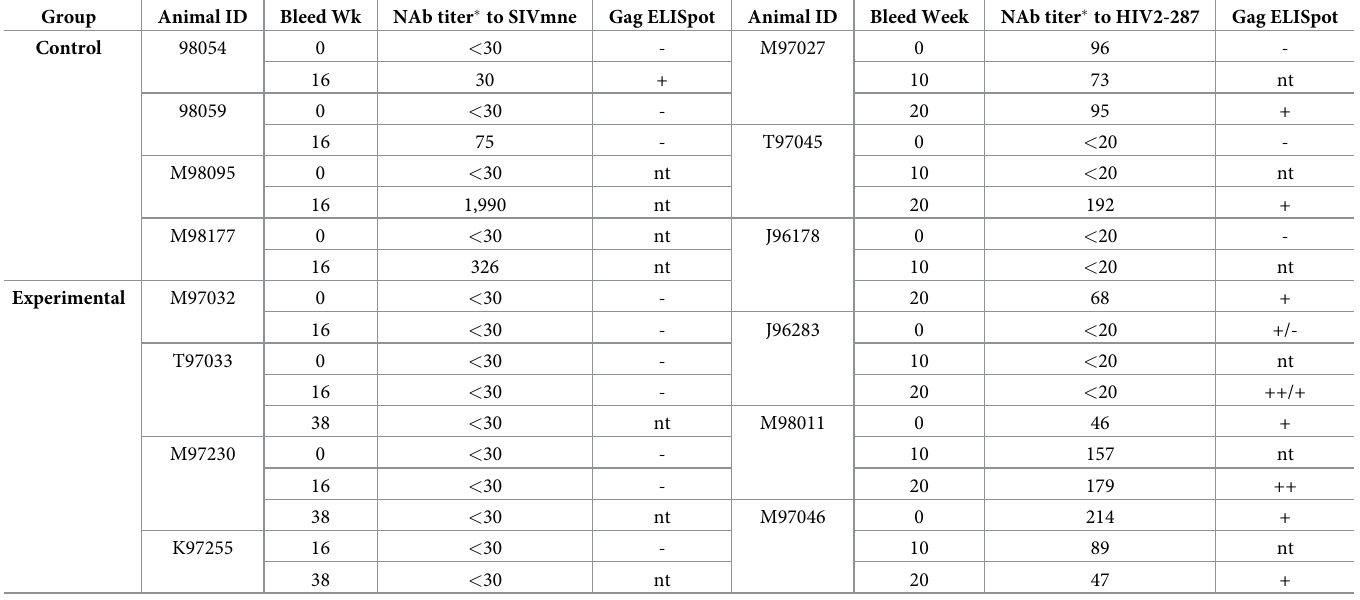
(Fig 2A). Neutralizing antibodies were not induced by the vaginal exposures during tenofovir pro- phylaxis assessed in sera at Study Week 20 just prior to viral challenge. However, neutralizing antibodies were detected in infected control animals, and in all experimental macaques once infected by a challenge virus (Table 1). Table 1. Infected control animals and virus challenged experimental macaques demonstrated detectable neutralizing antibodies and cellular immune responses. A . NAb titers to SIVmne and Gag ELISpot results for control an experimental macaques at study weeks 0,16, and/or 38. B . NAb titers to HIV2-287 and Gag ELISpot results for control an experimental macaques at study weeks 0, 10, and